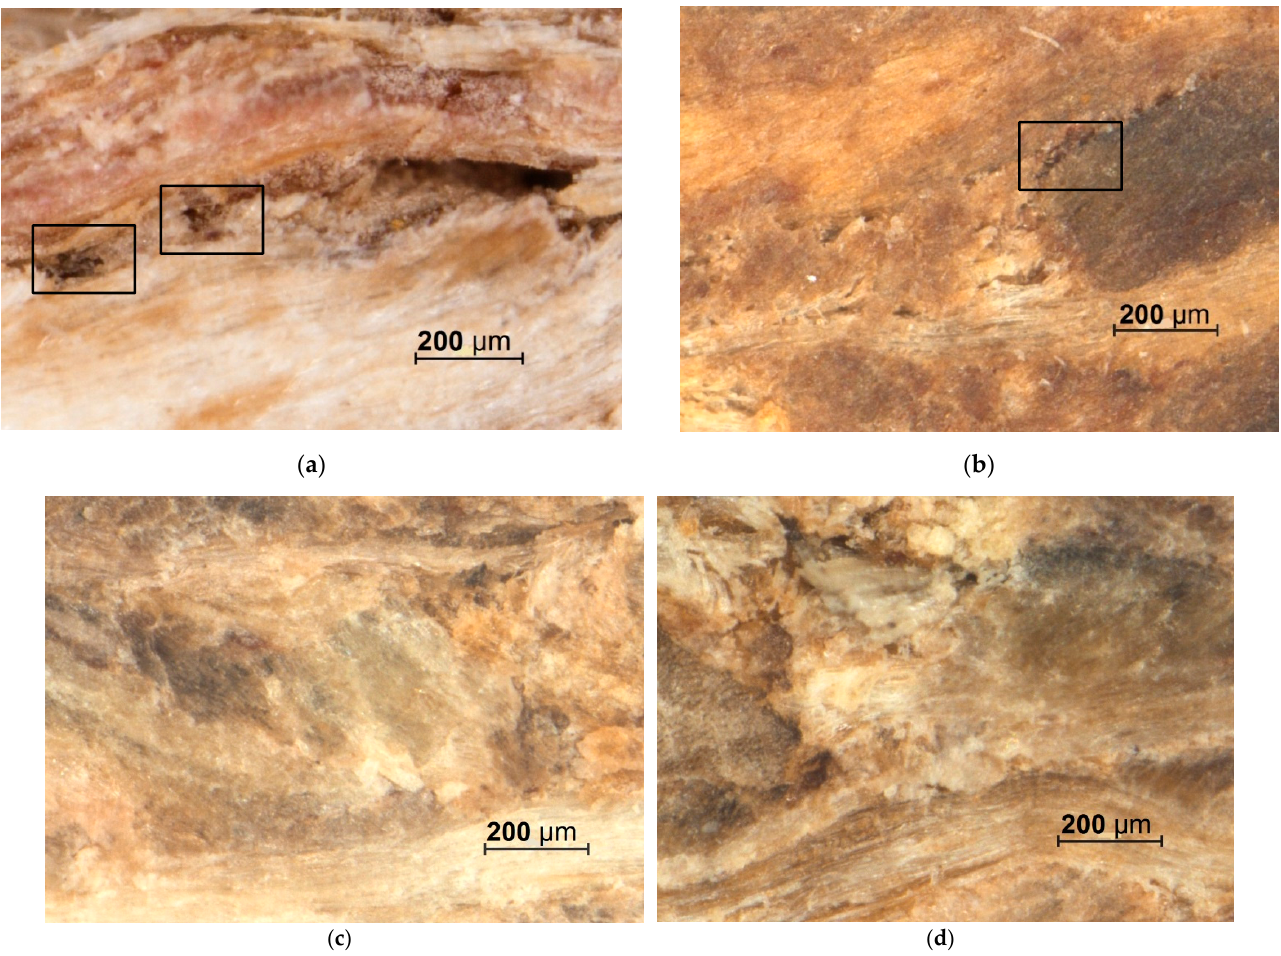
Figure 5. Microscopic investigation of the panels’ structures, 180× magnification: ( a ) LO20; ( b ) LO 20 P2; ( c ) LO 20 P1G; ( d ) LO 20 P2G. The marked areas represent the interface between wood particles and adhesive agglomeration.